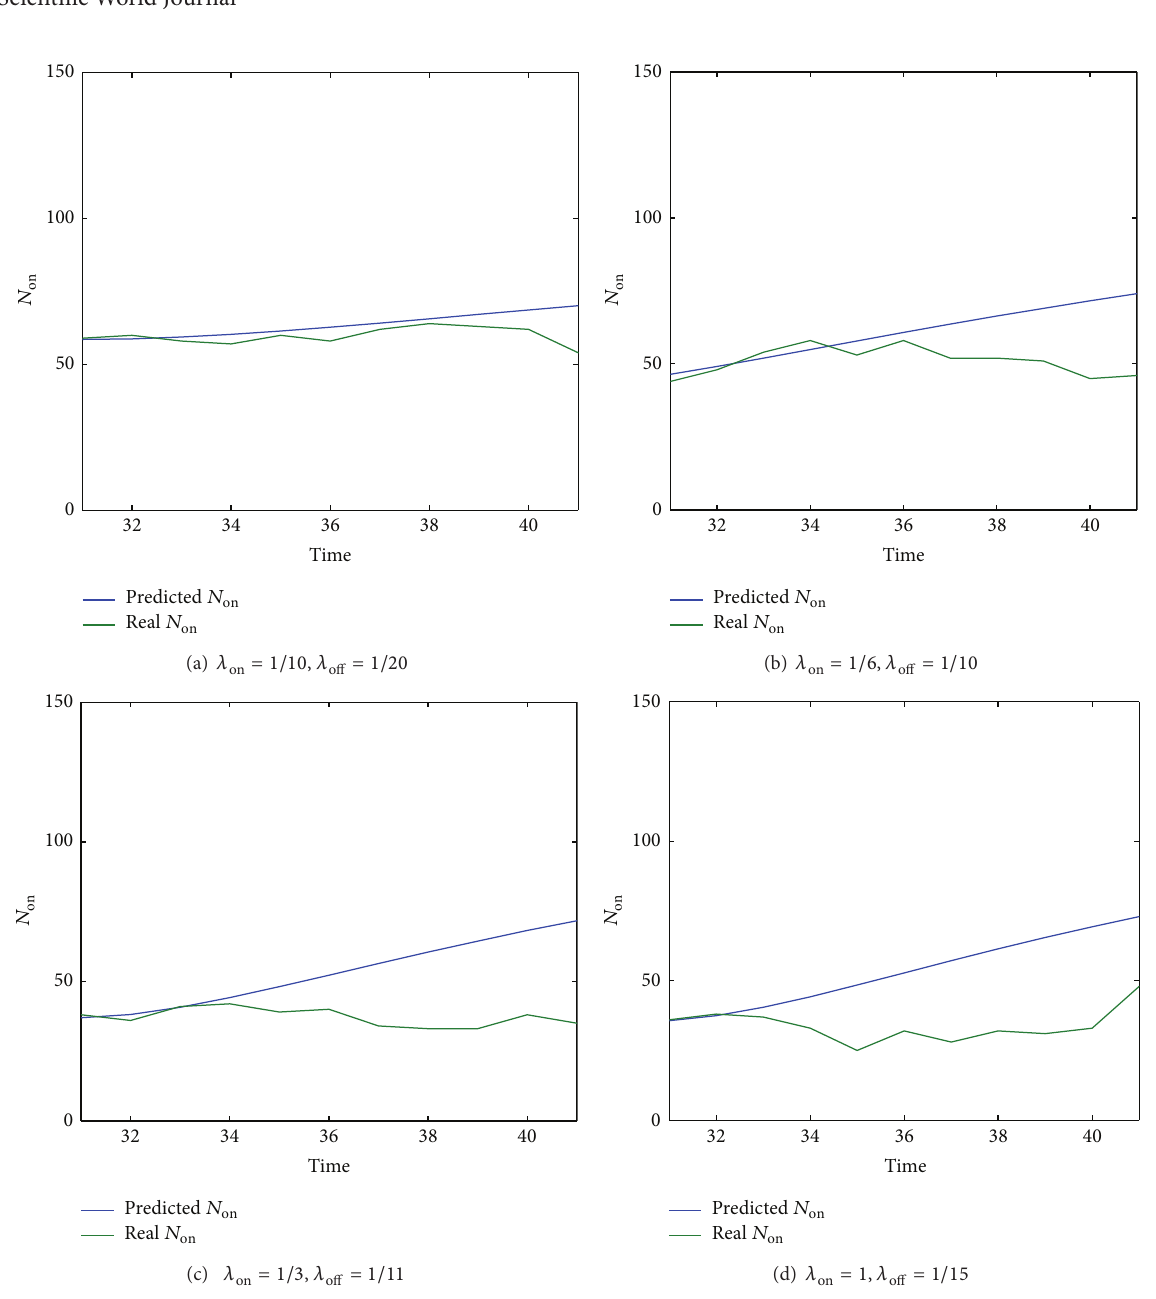
Figure 7: The accuracy of prediction model over